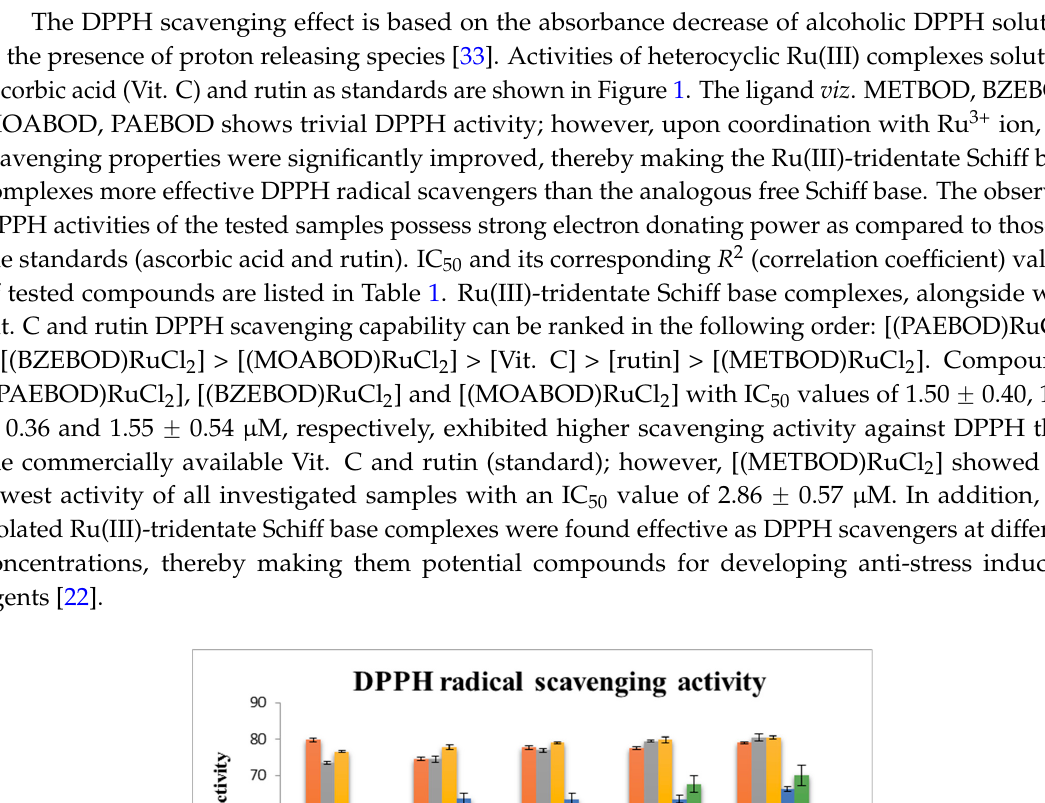
Table 1. The IC 50 values of DPPH- and ABTS-scavenging activity of heterocyclic Ru(III) complexes compared to a standard anti-oxidant drug.